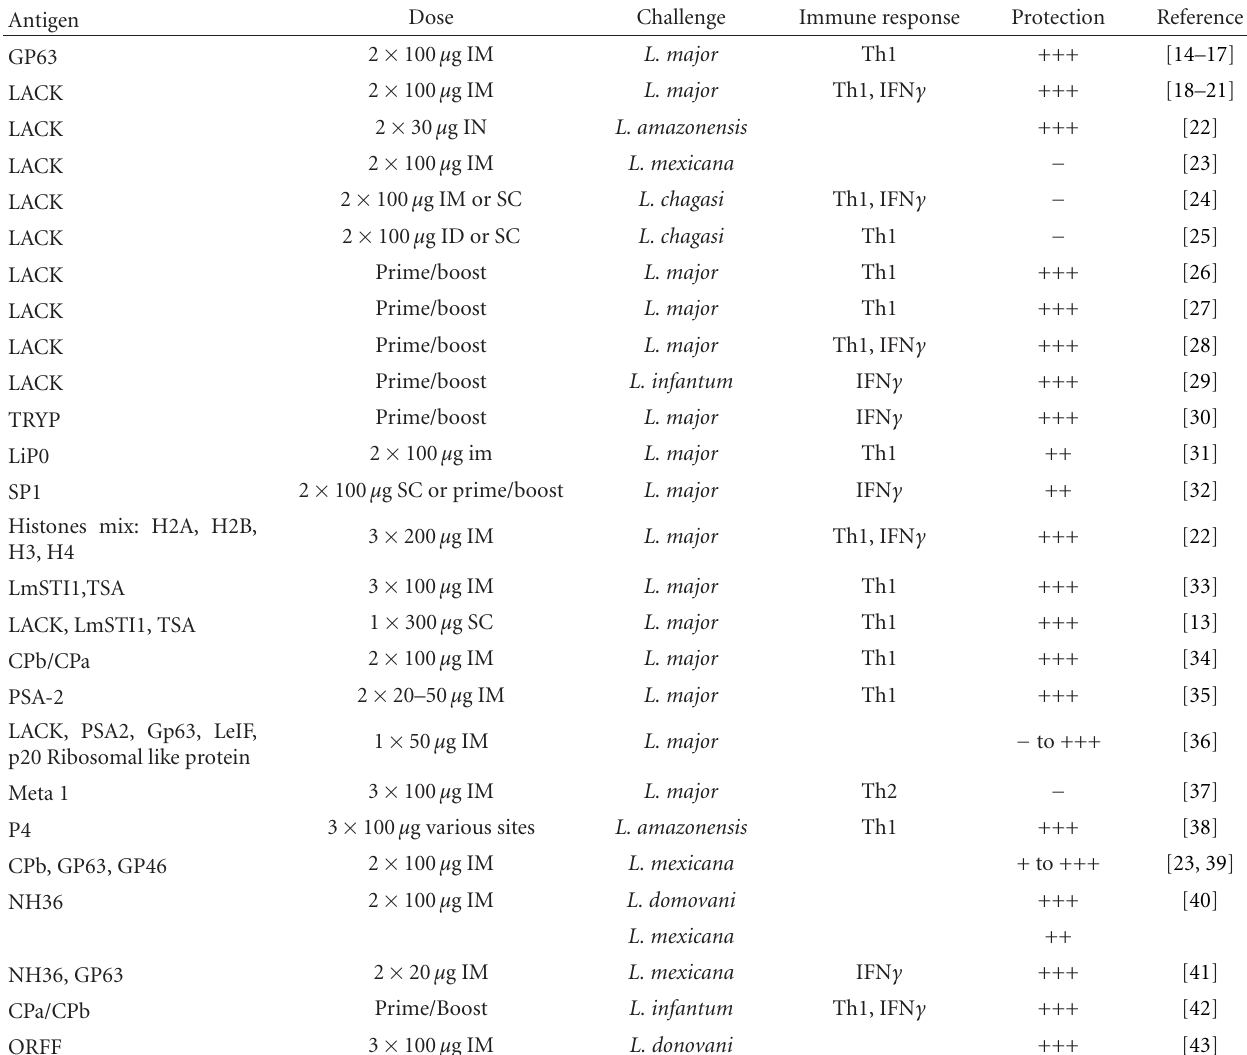
Table 1: DNA vaccines tested against murine